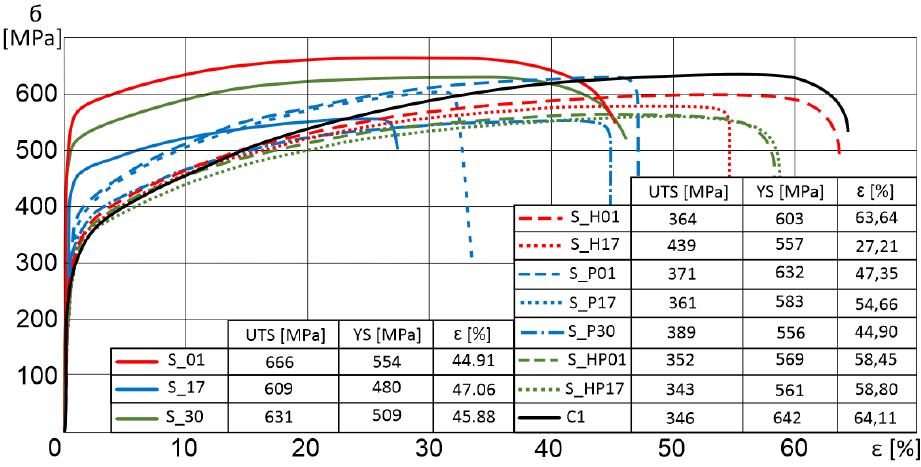
Figure 4. Strain-stress curves for S_01, S_17, and S_30 samples after different types of heat treatment with the additional course of conventionally made material.